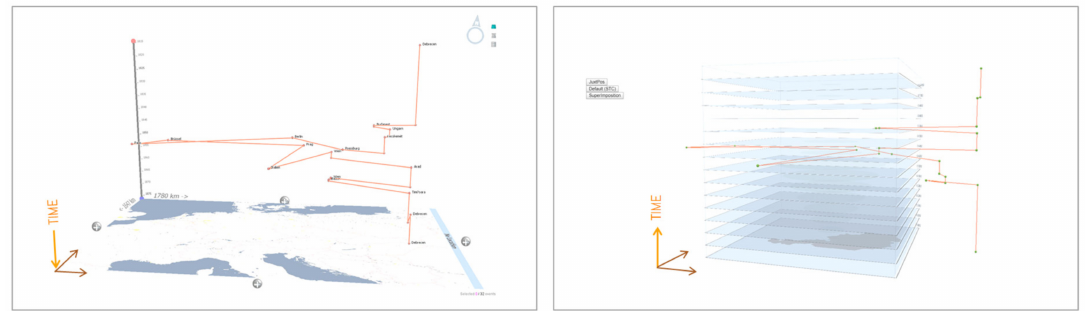
Figure 5. Space–time cube representation of the life-path of the Austro-Hungarian opera singer and director, Joszef Szabo (1816–1875) by the GeoTime suite ( left ) and by the web-based PolyCube system ( right ).